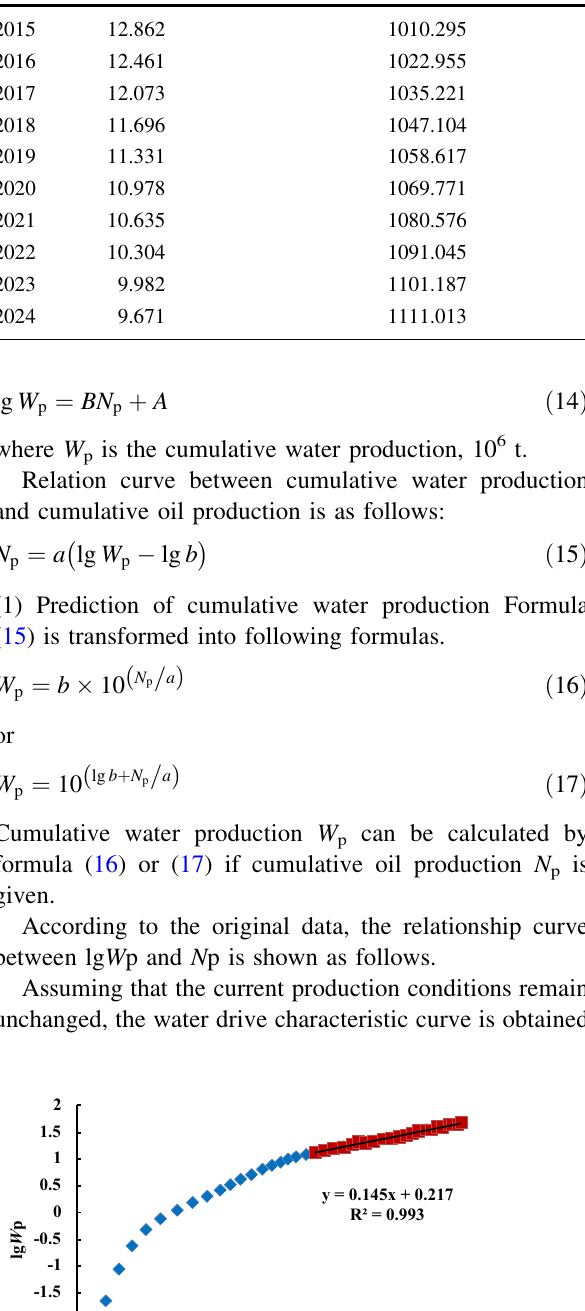
Table 3 Results of predicted oil production rate and cumulative oil production of future 10 years Year Predicted oil production rate ( 9 10 4 t/a)